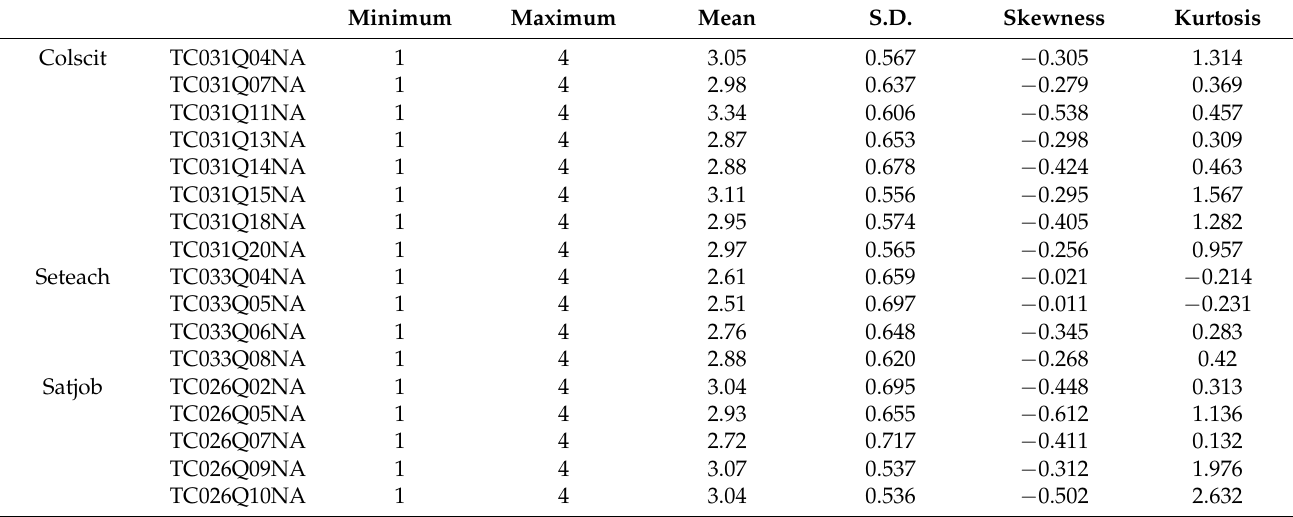
Table 2. The descriptive statistics of each variable observed ( n = 945).